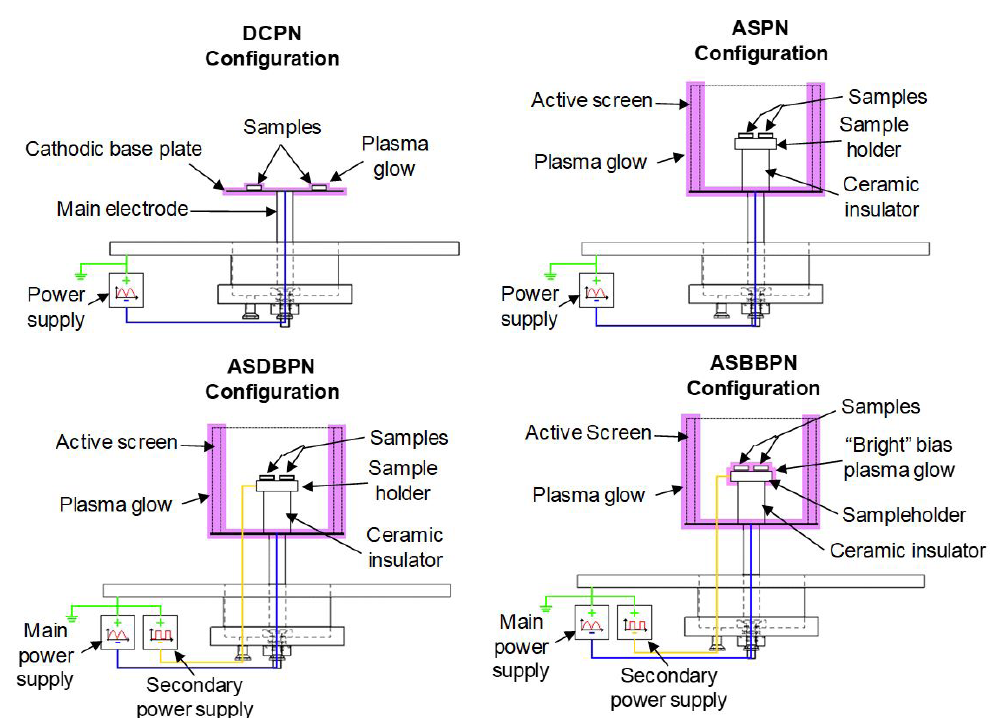
Figure 1. Diagrams for the different treatment